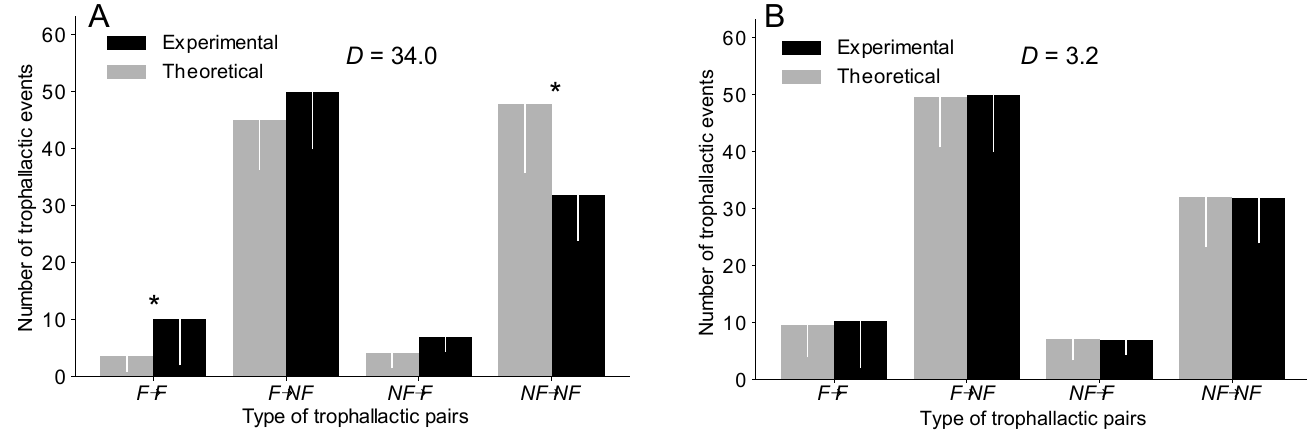
Figure 2. Comparison of the number of each type of trophallactic pairs between the experiments and the simulations implemented based on a delta distribution in the OC version ( A ) and in the TEC version ( B ). * = MW with a p < 0.05. Error bar = standard deviation. D = sum of the difference in the number of trophallactic pairs of each type ( F → F , F → NF , NF → F , NF → NF ) between the experiments and the simulations. See Figure S3 for the uniform and exponential distributions and Table S1 for details.